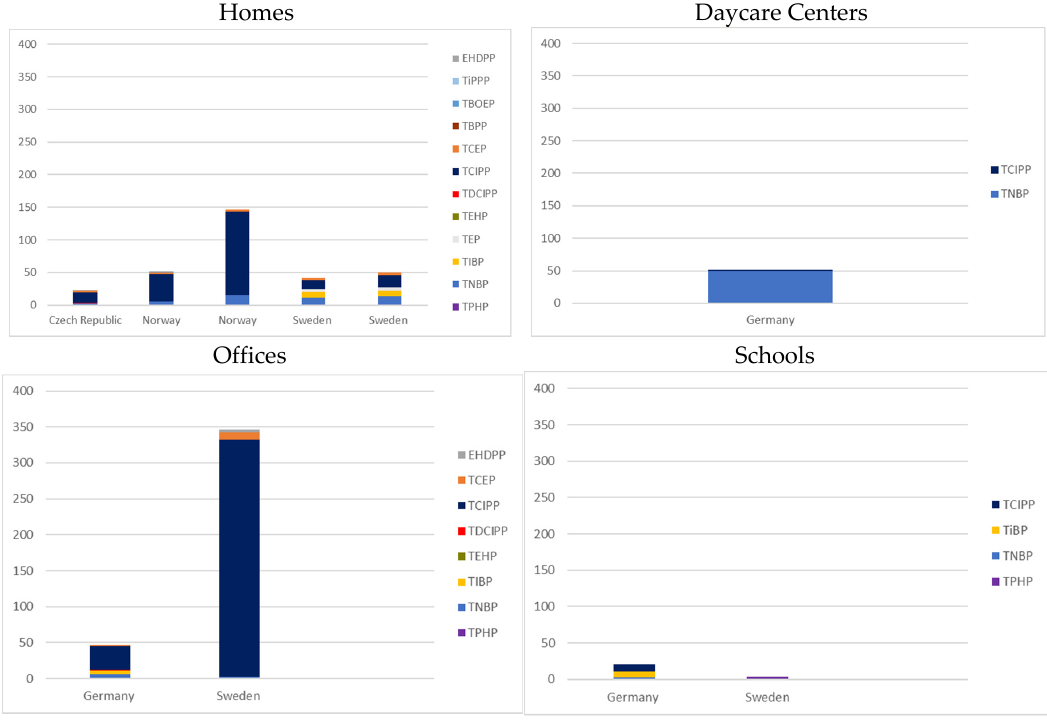
Figure 2. OPFRs air median concentration in Europe, 2000–2018 (ng/m 3 ) (one bar per article). To conclude on European indoor air, the two predominant compounds in air were TCIPP and TNBP, thus confirming previous findings from Wei, who noticed it was not specific to Europe [39]. TCIPP dominated in homes and offices, followed by TNBP, whereas in German daycare centers TNBP concentrations were higher than those of TCIPP.